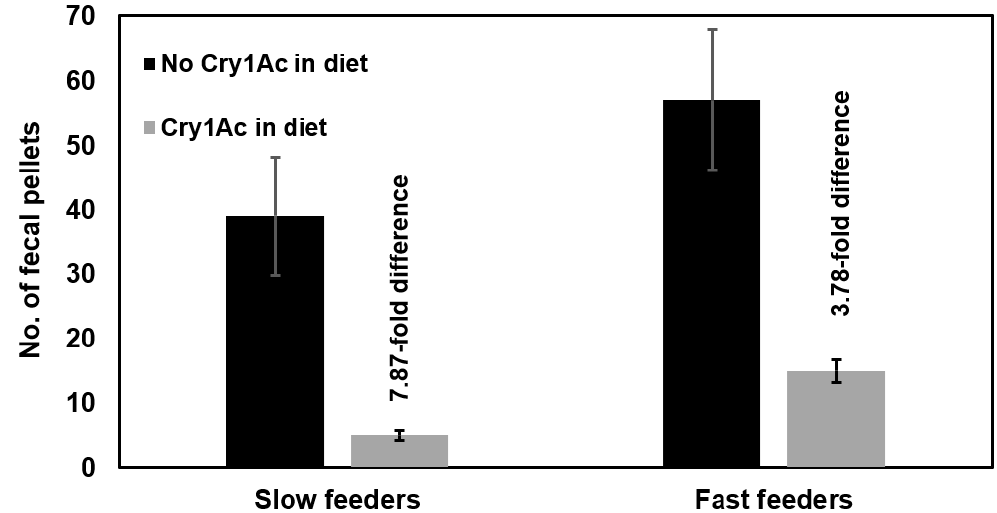
Figure 3. Fecal production for Cry1Ac-susceptible Helicoverpa zea neonates (slow versus fast feeders, see Figure 2) over a 24 h incubation period on artificial diet without Bt versus with a diagnostic dose of MVPII in the diet (using the feeding disruption assay). Slow feeders demonstrated an increased susceptibility to MVPII. Error bars are ±1 standard error of the mean (n =20 for each treatment).